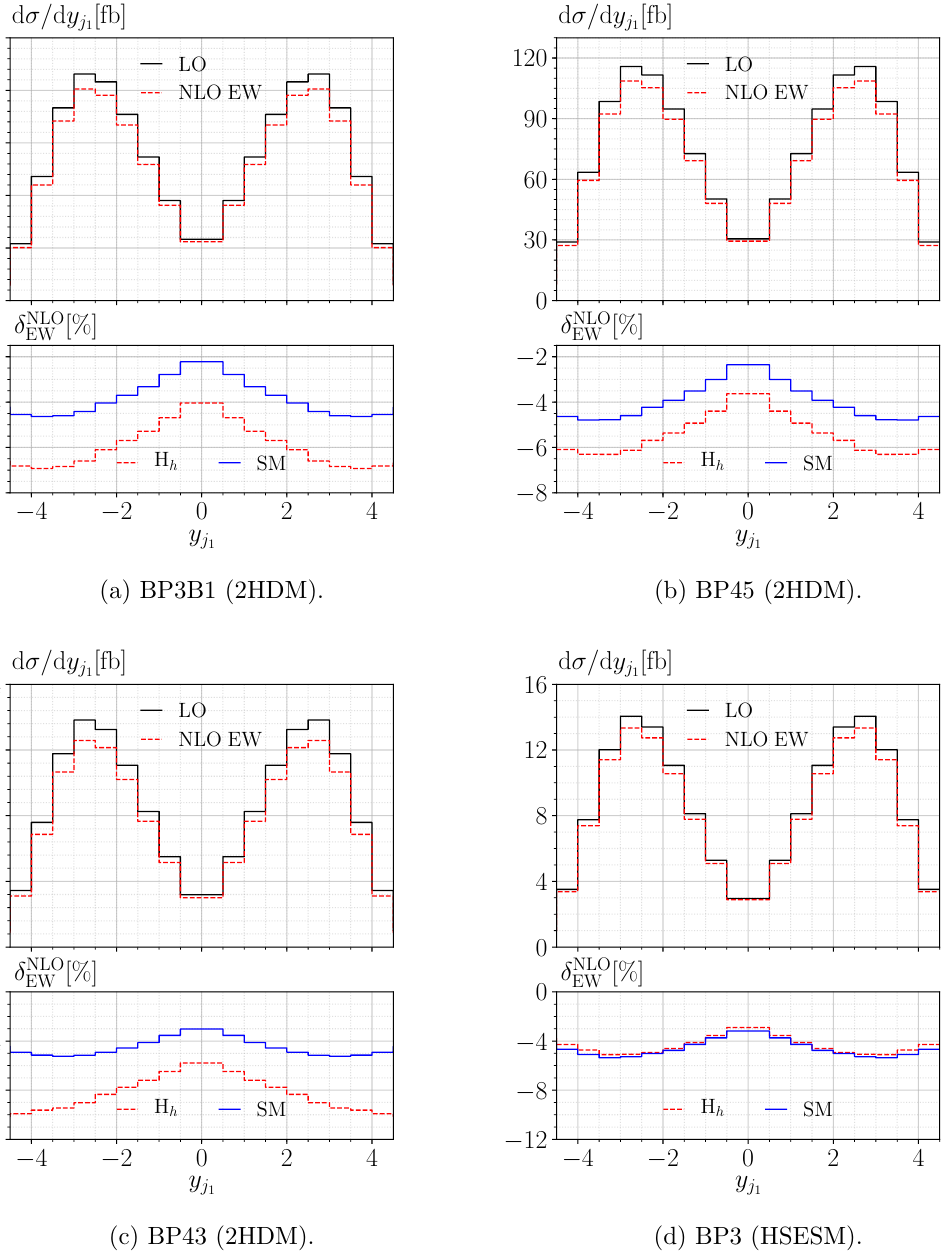
Figure 8. Distributions in the rapidity of hardest jet y the benchmark points BP3B1 in (a), BP45 in (b) and BP43 in (c) in the 2HDM, and BP3 in (d) in the